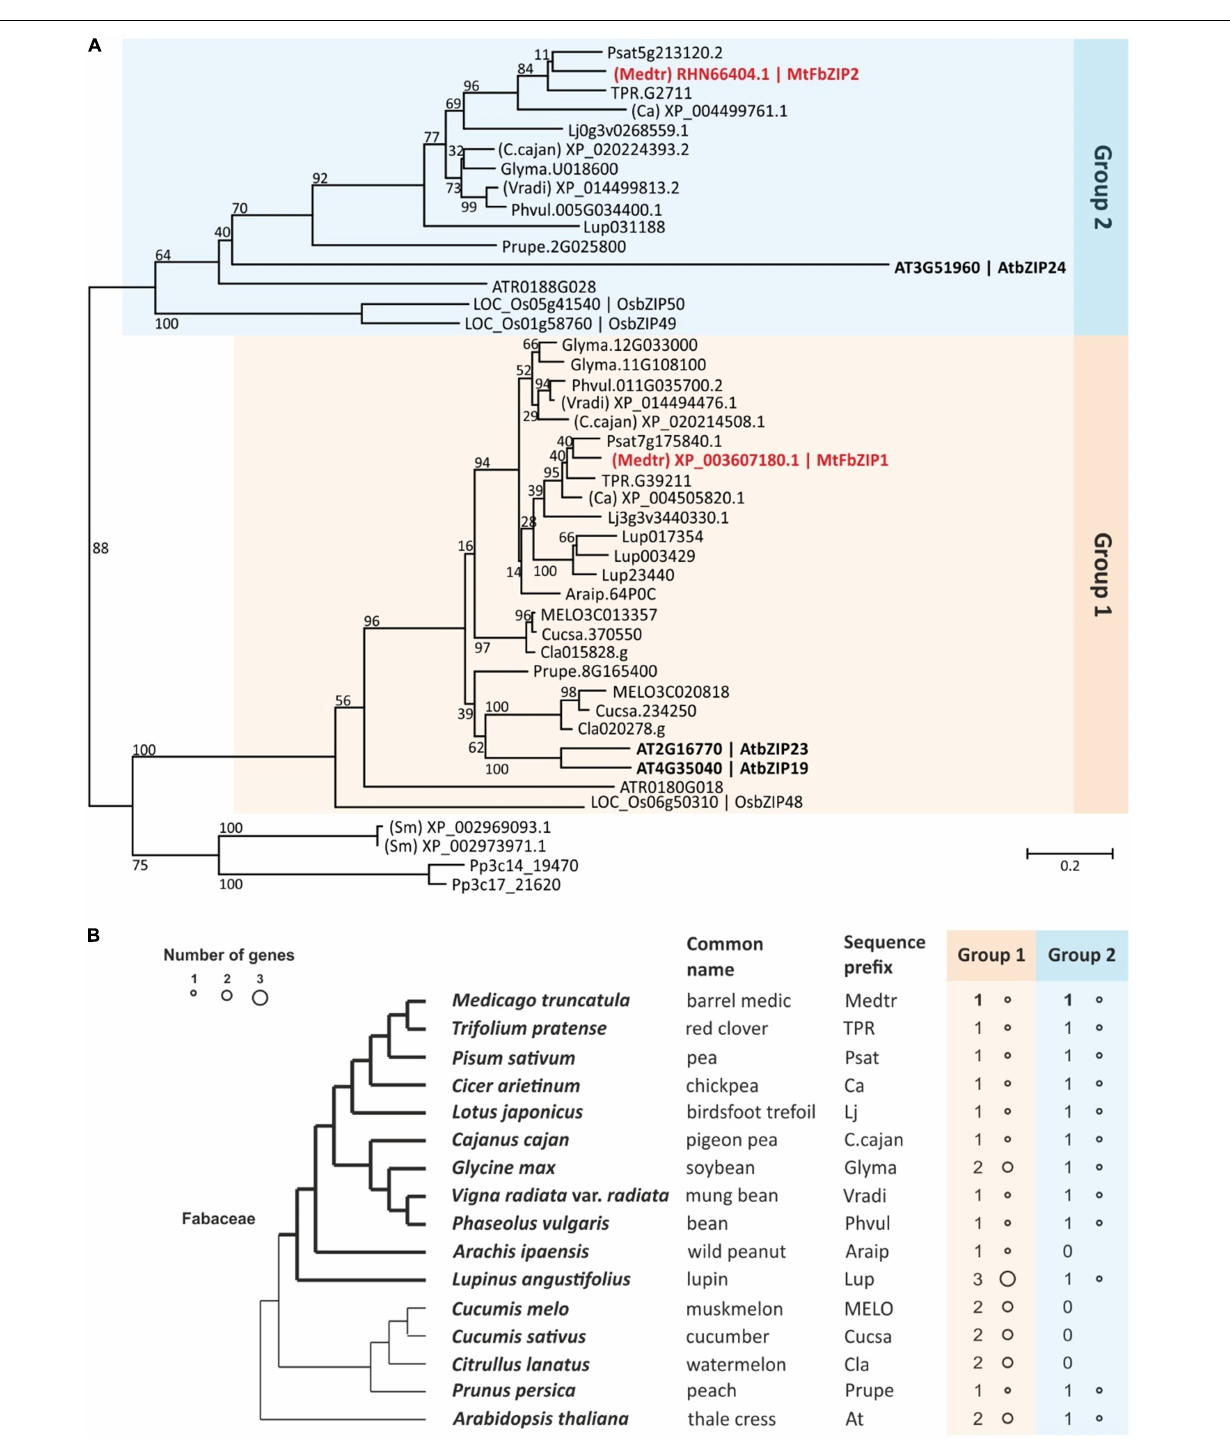
FIGURE 1 | Phylogenetic analysis of the F-bZIP proteins in Fabaceae species. (A) Phylogenetic tree representing 11 species from the Fabaceae family, four species from the clade Fabids but not from the Fabaceae family ( Cucumis melo , Cucumis sativus , Citrullus lanatus , and Prunus persica ), and five representative species from major plant taxa ( Physcomitrella patens (Pp), Selaginella moellendorffii (Sm), Amborella trichopoda (ATR), Oryza sativa (LOC_OS), and Arabidopsis thaliana ). The species prefix of the 11 Fabaceae species, the four non-Fabaceae Fabid species and the five species representing major taxa are indicated here (above) and in panel (B) . The phylogenetic tree was constructed using maximum-likehood and shows bootstrap support from 1,000 replicates (numbers on each branch represent the percentages of bootstrap). (B) F-bZIP gene enrichment for the species from the Fabaceae family, non-Fabaceae Fabids and A. thaliana analyzed in the phylogeny. Circle size represents the number of genes for each species in Group 1 and Group